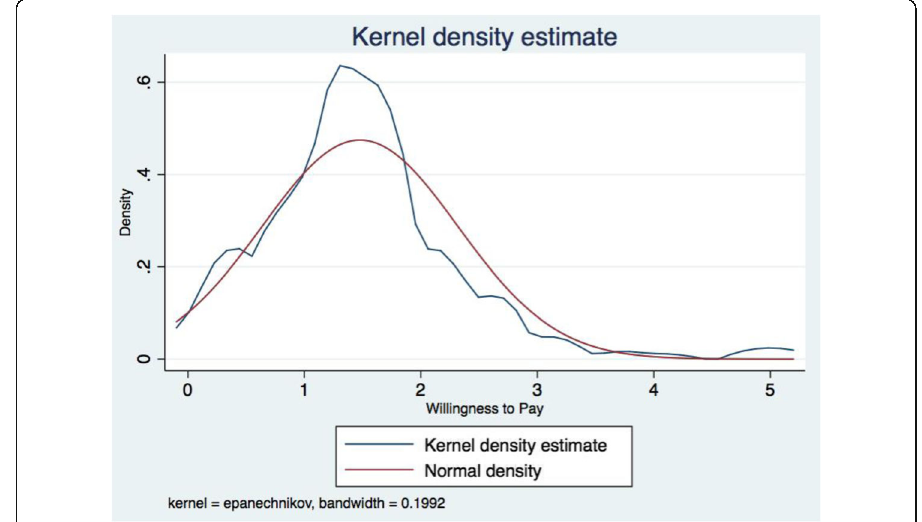
Fig. 2 Kernel density estimate and normal density of WTP among participants willing to